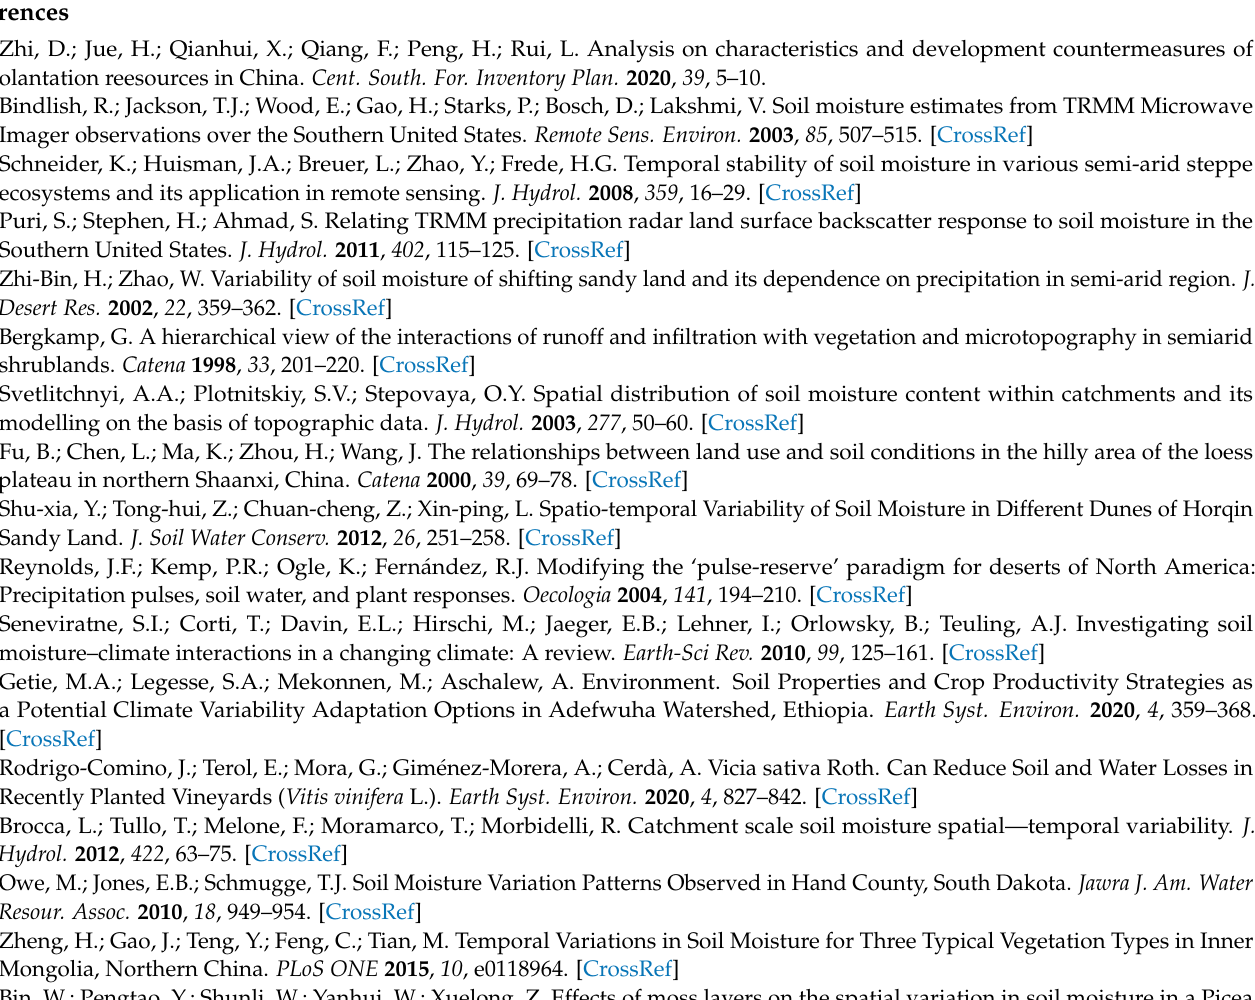
Figure A2. Rainfall measurements (( A ): half-hourly rainfall; ( B) : daily rainfall).